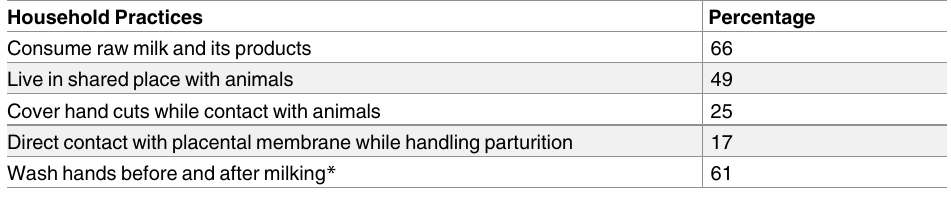
Table 8. Household practicesthat pose risk for brucellosis transmission reported by smallholder dairy farmersparticipating in a cross-section study on brucellosis in Pakistan ( n = 420